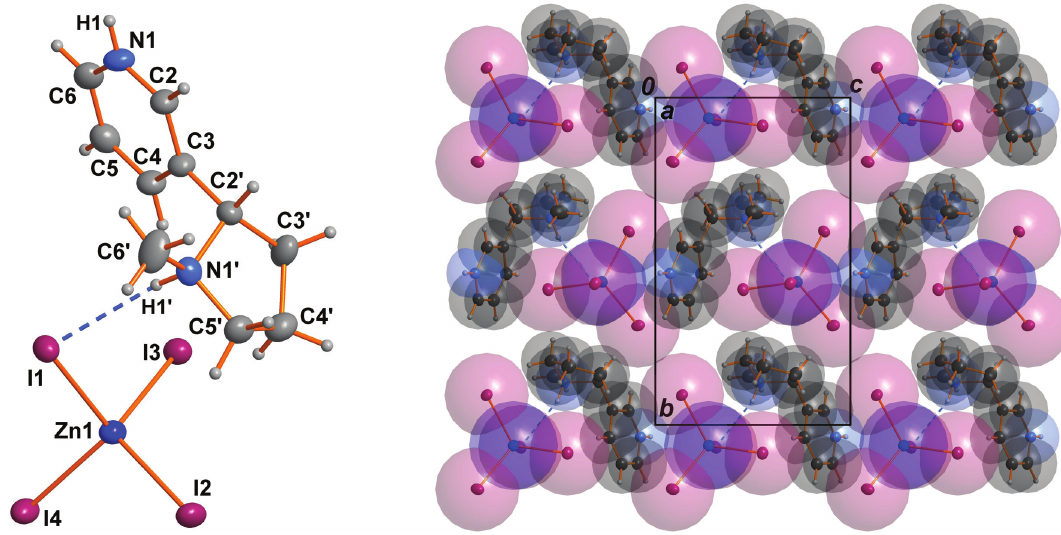
Table 1: Data collection and